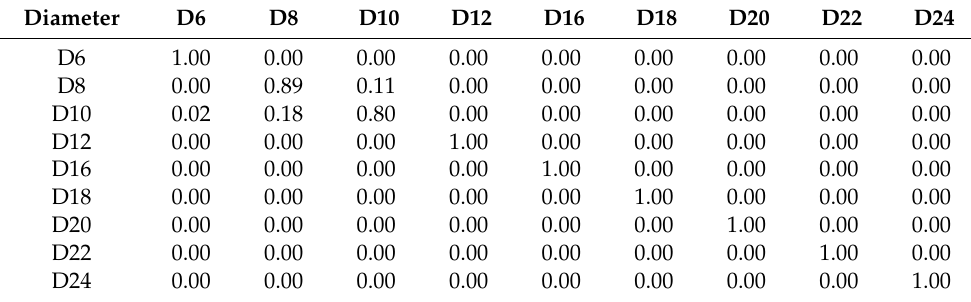
Table 7. Confusion matrix obtained by CNN network on field